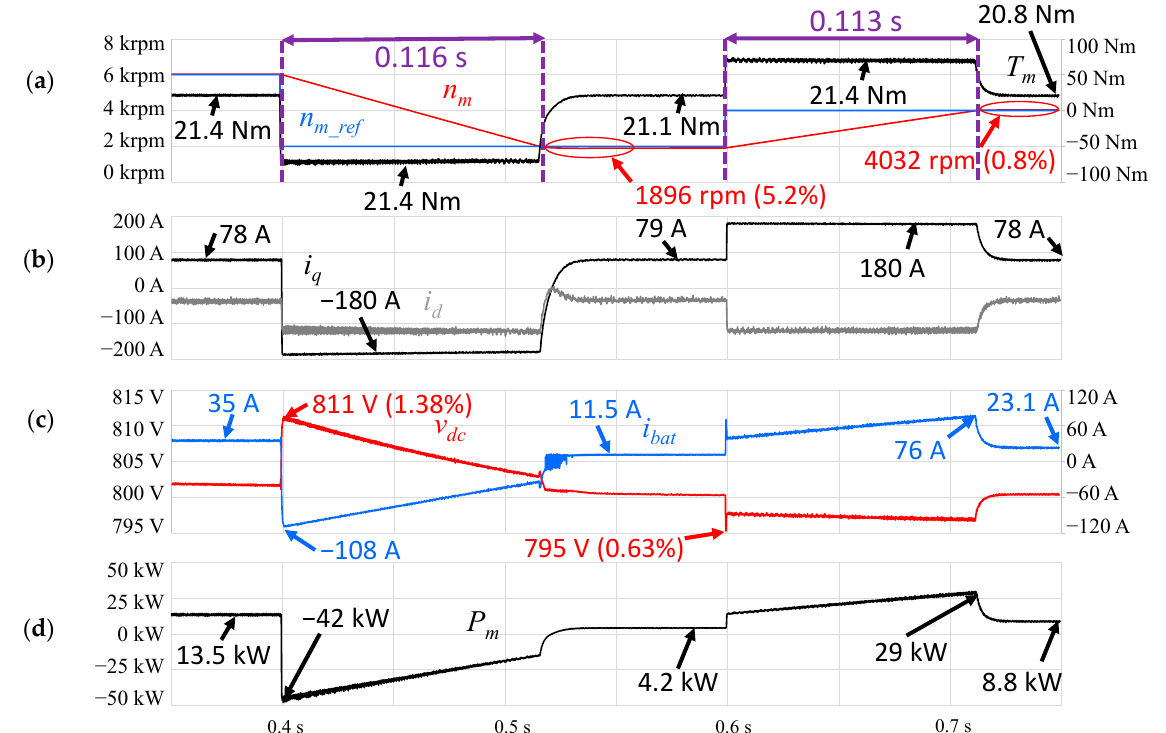
Figure 9. Simulation results of the traction system when varying the speed, coupled with a 20 Nm load, representing ( a ) the torque ( T m ), speed ( n m ) and reference speed ( n m_ref ) of the SRPM machine; ( b ) the stator windings’ currents ( i d , i q ); ( c ) dc link voltage ( v dc ) and battery current ( i bat ); ( d ) the power ( P m ) of the SRPM machine.